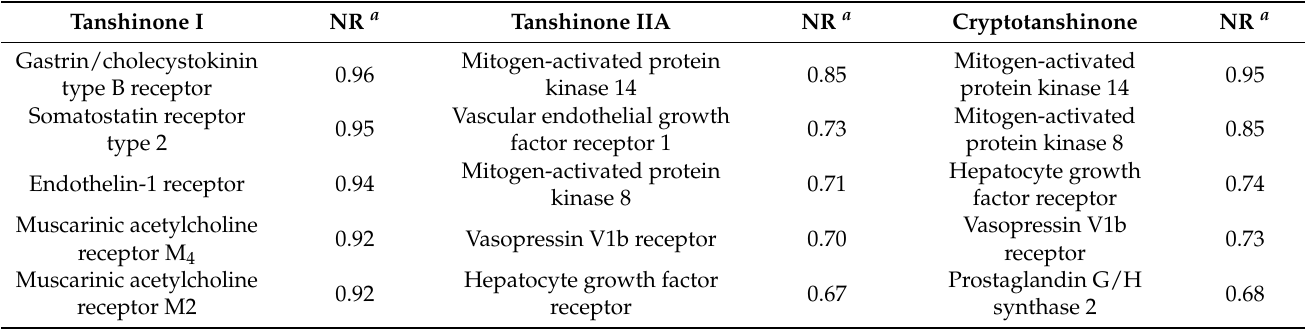
Table 2. List of the top ten protein targets for tanshinone I, tanshinone IIA, and cryptotanshinone from computational proteochemometric